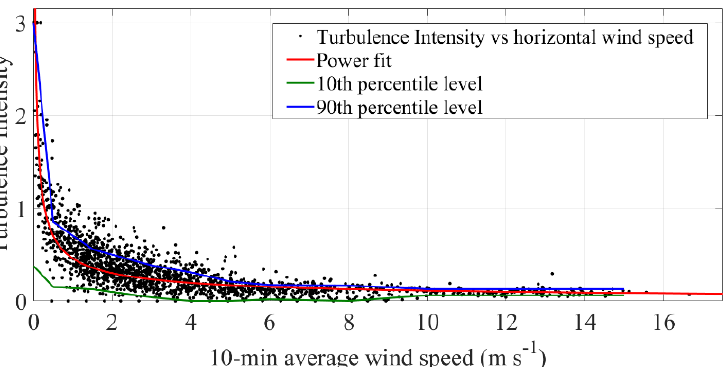
Figure 9. The turbulence intensity vs. 10-min average wind speed (m s − 1 ). The 90th and 10th percentile level for each wind speed class defined in Table 3 are shown in the blue and green curves, respectively. The relationship between turbulence intensity and 10-min average wind speed has been modeled by means of a power fit model (red curve).